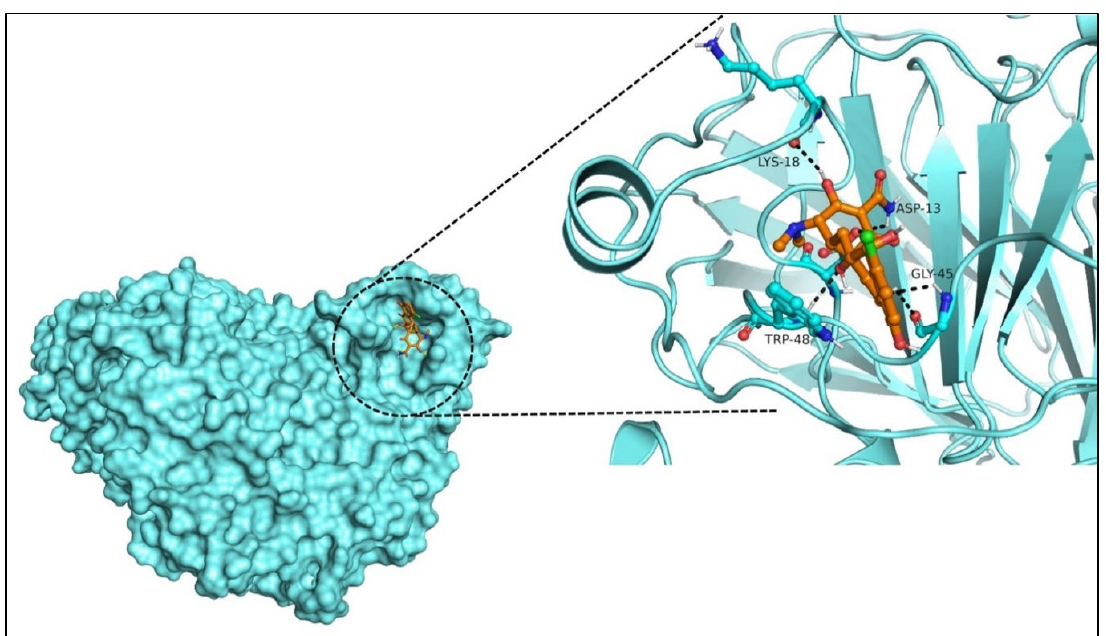
Figure 8. Second best-docked pose of Demeclocycline with Alpha Glucosidase in surface form (left image) and ligand–receptor interactions in cartoon form (right image).